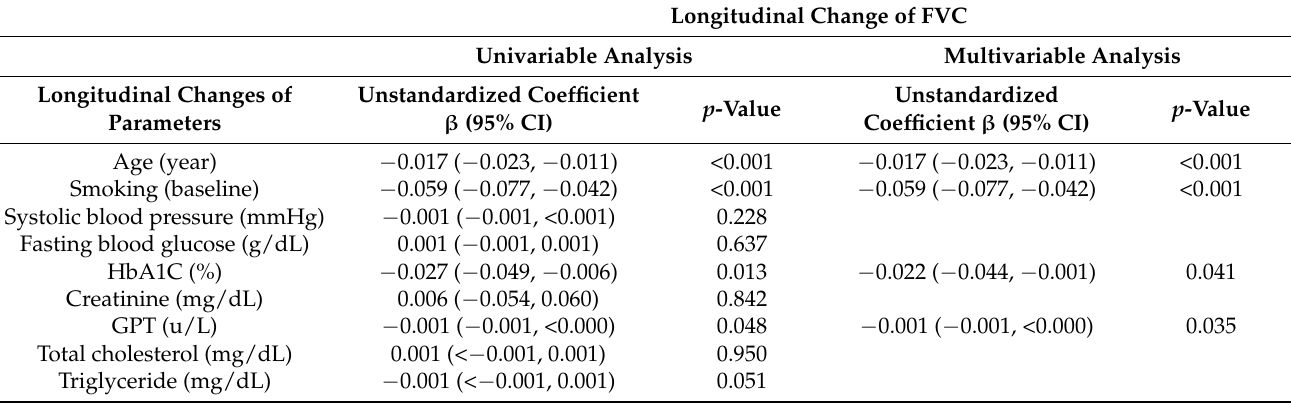
Table 4. Univariable and multivariable linear regression analyses for longitudinal changes of FVC.